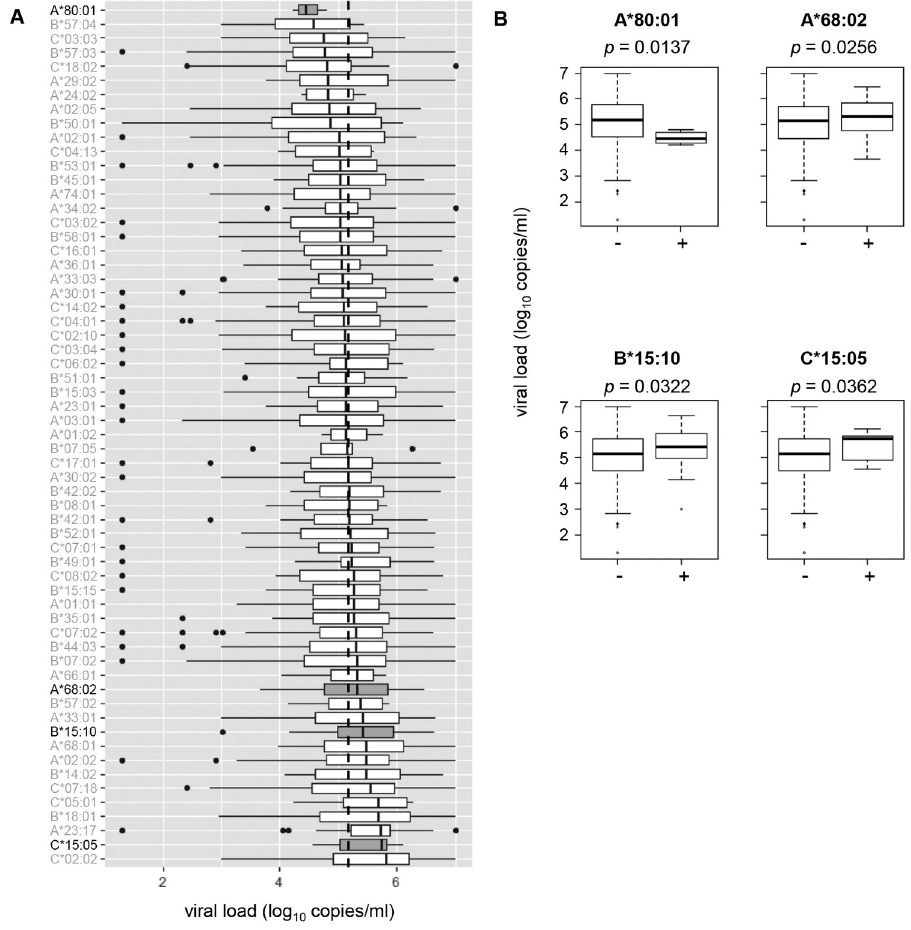
Fig 4. Association between HLA class I allele expression and viral loads. A. Association of individual HLA class I alleles (61 alleles with higher than 1% population frequencies) with viral loads. Vertical dotted line indicates cohort median viral load. Shading box indicates p < 0.05. B. Comparison of viral loads between individuals with and without each HLA allele that showed a significant association in